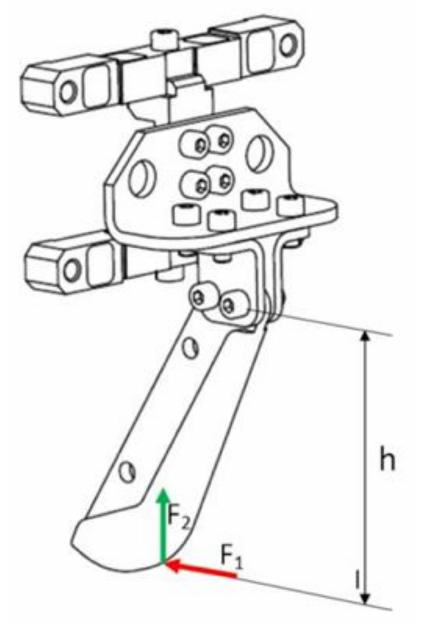
Figure 3. System of loads acting on the